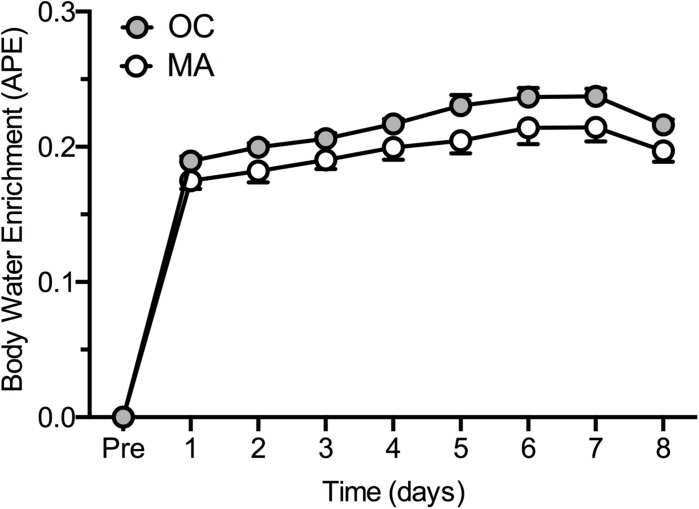
Body water 2H enrichment (Atom Percent Excess; APE) in older untrained controls (OC, gray circles) and Master Athletes (MA, white circles). Values are presented as means ± SEM.